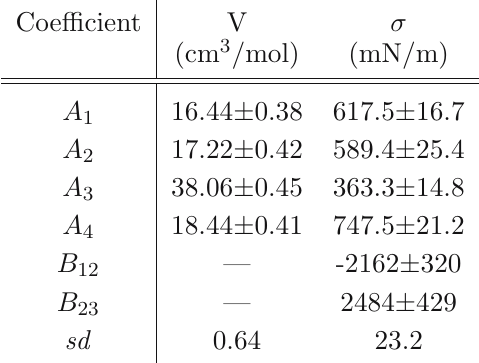
Table 5 Coefficients A , B , and the standard deviations of approximation of the fit in i ij the system CaO-FeO-Fe 2 O 3 -ZnO at the temperature of 1573 K.